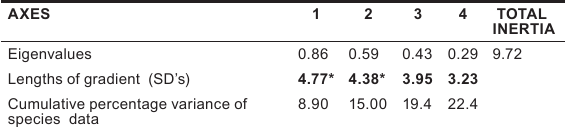
table 9 Species and growth form relations in Variant 2b